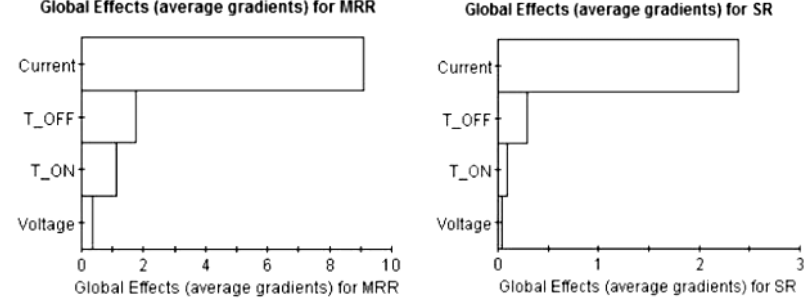
Figure 5. Effects of input parameters on output parameters.